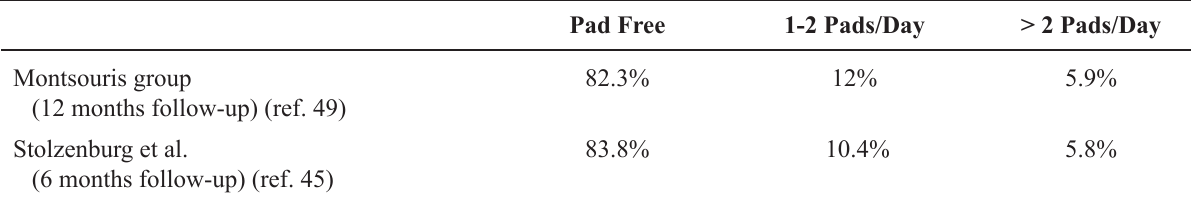
Table 10 – Continence between 2 series using the same validated